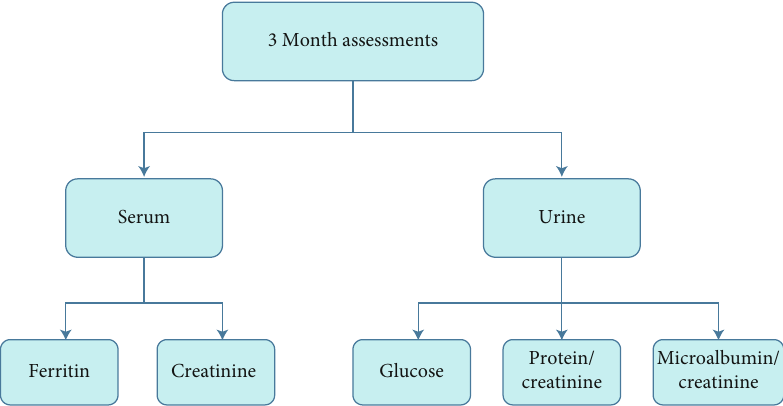
Figure 4: Semantic network representation of the three-month follow-up assessments.